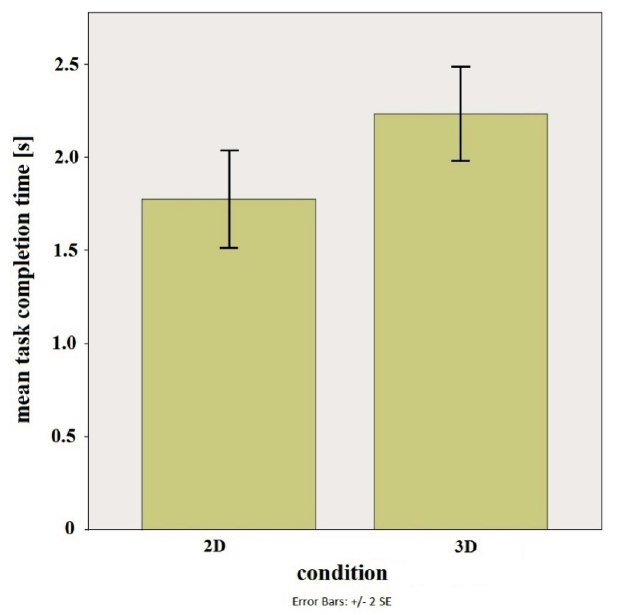
Figure 11. Mean task completion times for the interaction with the objects in 2D and 3D.